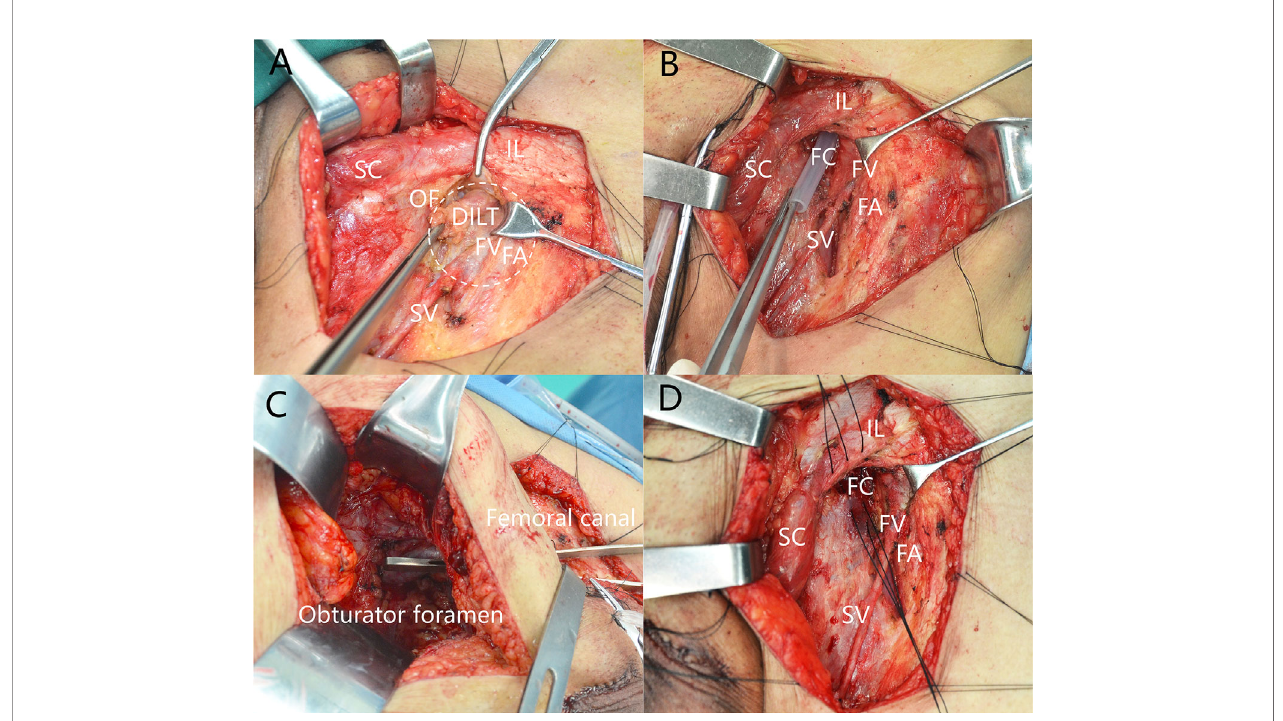
FIGURE 1 | Deep inguinal lymph nodes dissection. (A) Position of deep inguinal lymph nodes. (B) The femoral canal is empty after removal of DILT. (C) Femoral canal communicates with obturator after removal of DILT and pelvic LNs. (D) Closing the femoral canal. DILT, deep inguinal lymphatic tissue; FA, femoral artery; FC, femoral canal; FV, femoral vein; IL, inguinal ligament; OF, oval fossa; SC, spermatic cord; SV, saphenous